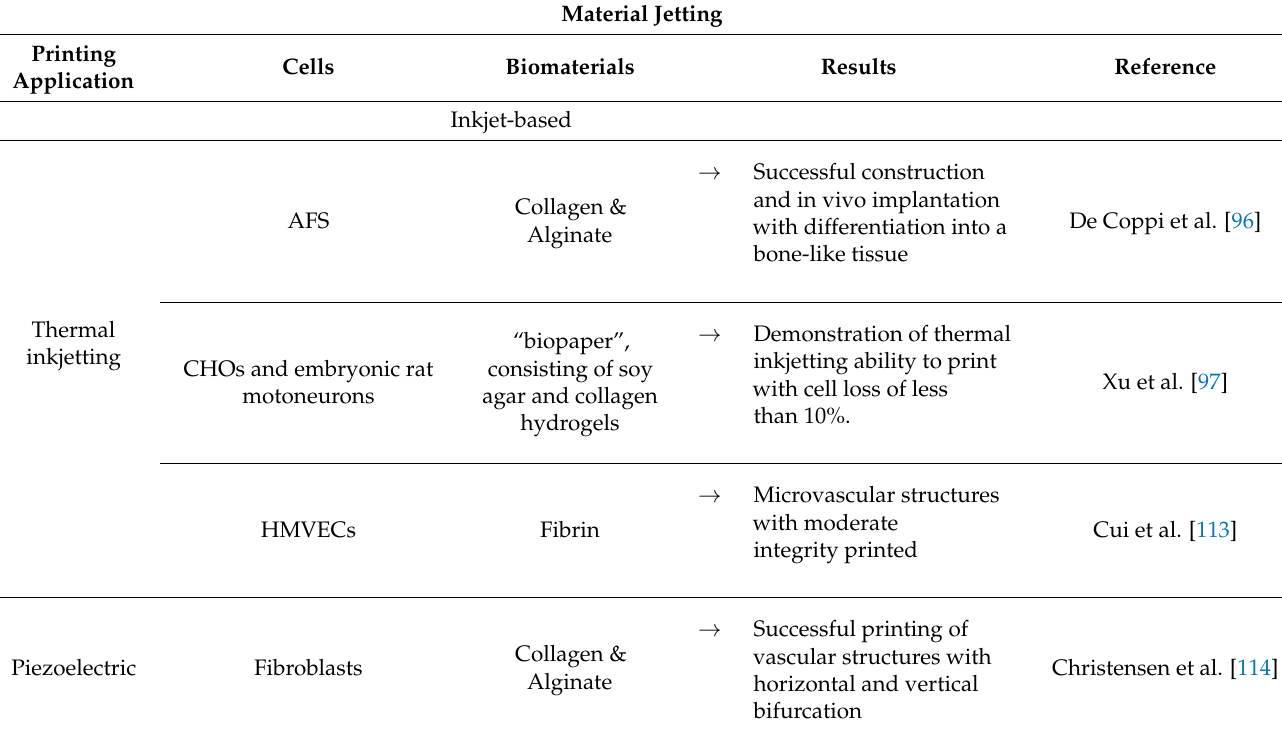
Table 3. Material jetting—based printing technologies in tissue engineering: Overview of recent study results. AFS: amniotic fluid-derived stem cells; CHO: Chinese hamster ovary; HMVEC: human microvascular endothelial cell; PEG: polyethylene glycol; BM-MSC: bone marrow-derived mesenchymal stem cells; hESC: human embryonic stem cell; hiPSC: human induced pluripotent stem cell; NHDF: neonatal human dermal fibroblast; NHEK: neonatal human epidermal keratinocytes; FB: fibroblast; KT: keratinocyte; hMSC: human mesenchymal stem cell; PCL: polycaprolactone; LIFT: laser-induced forward transfer; LAP: laser-assisted printing; LGDW: laser-guidance direct